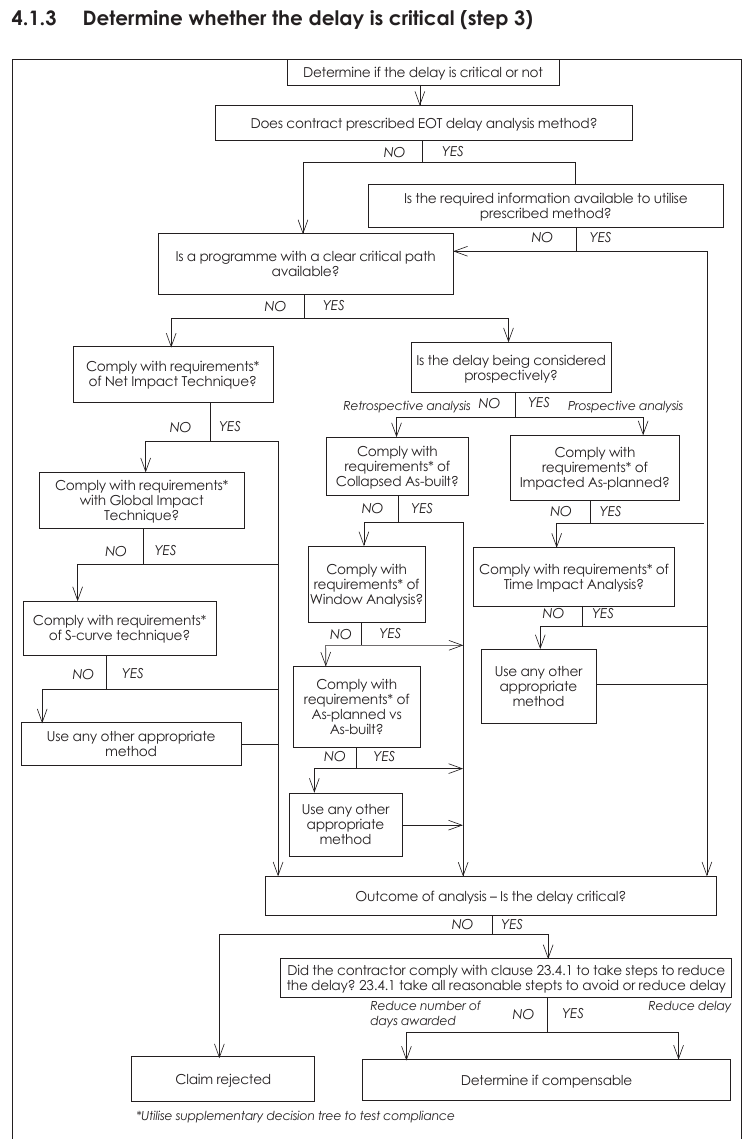
Figure 6: JBCC: Decision tree to determine if delay is